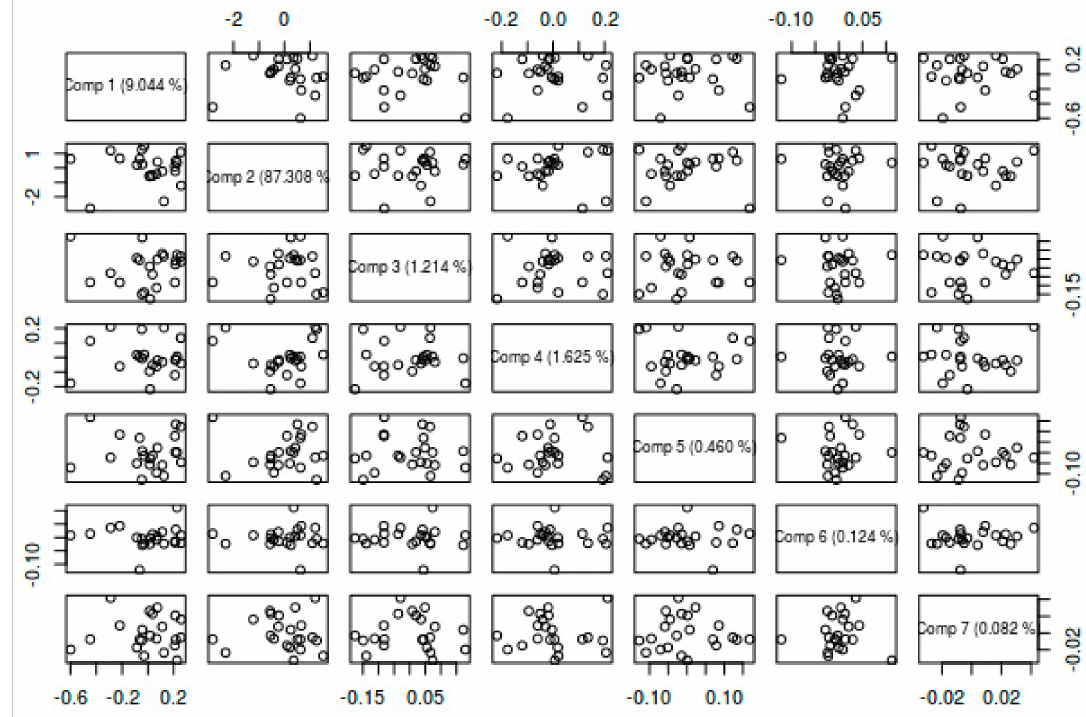
Figure 8. Score plot of the best model for first seven components.